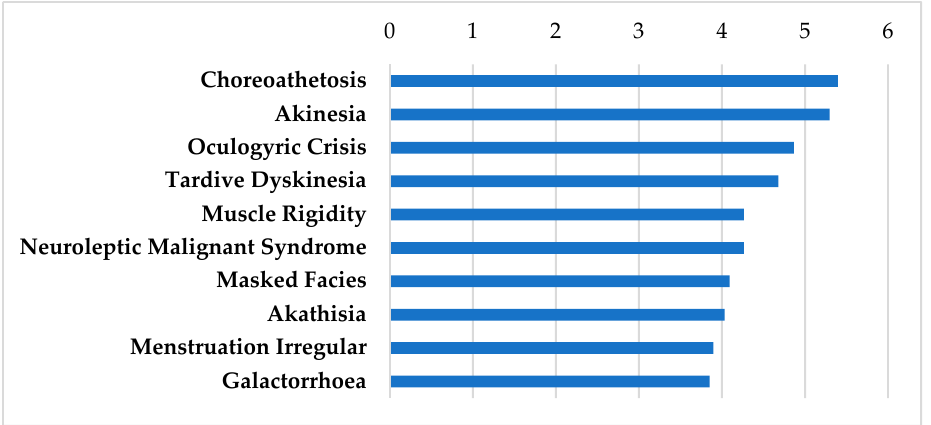
Figure 2. SIDER Side Effect Profile on antipsychotics. These drugs include aripiprazole, thioridazine, and loxapine. Frequencies of the top 10 side effects are shown based on the negative logarithm of their respective p values.